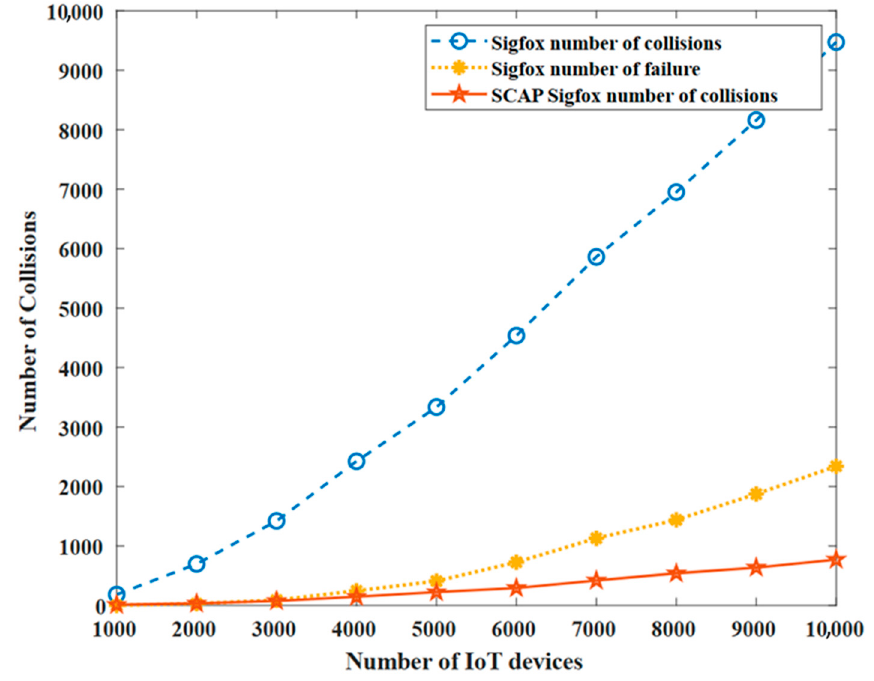
Figure 7. The number of collision and failure.